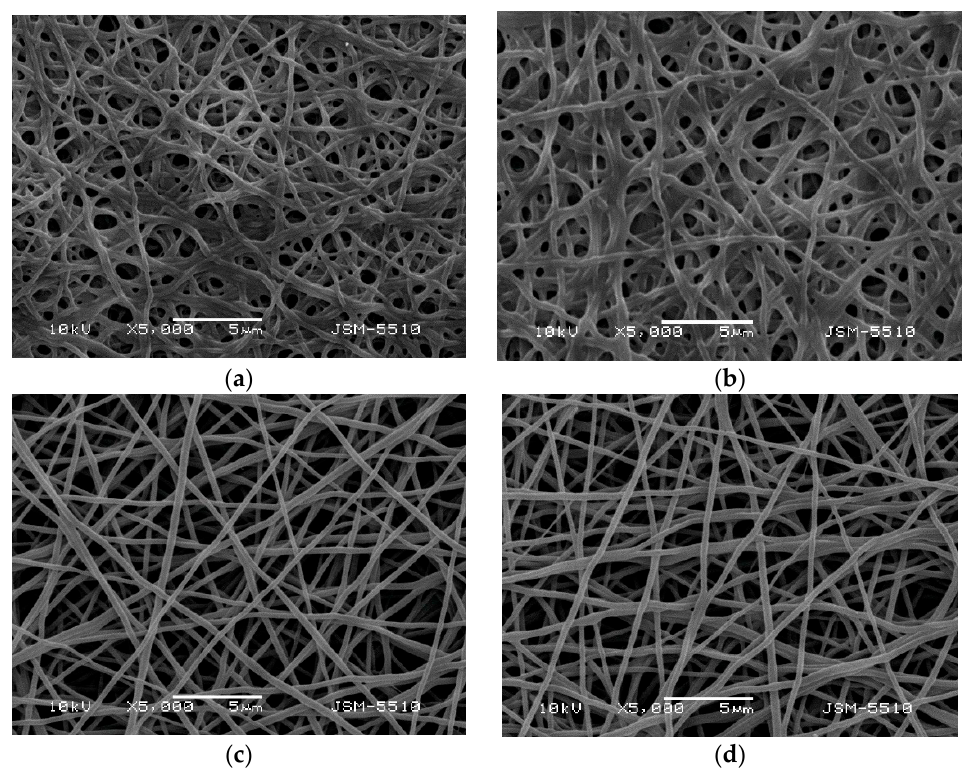
Figure 2. SEM micrographs of electrospun mats of: cr(PVA/Ch) (8:2 w / w ) ( a ) and cr(PVA/Ch)/SQ (10 wt% SQ) ( b ) after 24 h immersion in acetate buffer of pH 4.5; cr(PVA/Ch)/SQ (10 wt% SQ) after immersion in ethanol solution of CuCl 2 ( c ) and FeCl 3 ( d ) for 1 h.